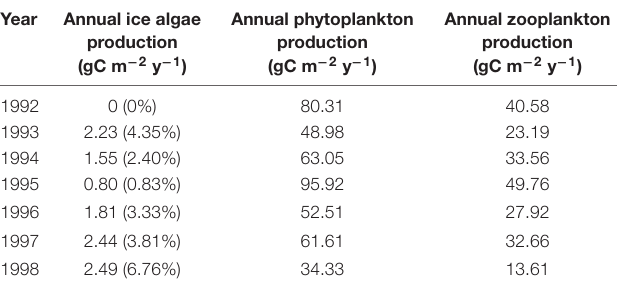
TABLE 5 | Annual production of ice algae, phytoplankton (diatom + flagellate), and zooplankton (microzooplankton + mesozooplankton) for the central Barents Sea station over the 7 years simulated